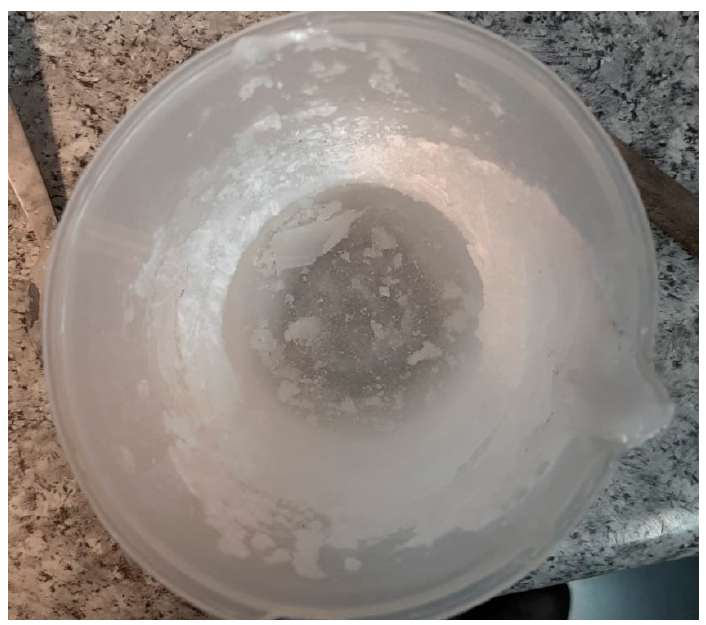
Figure 9. Crystallized sodium hydroxide from the alkaline solution of Method II.